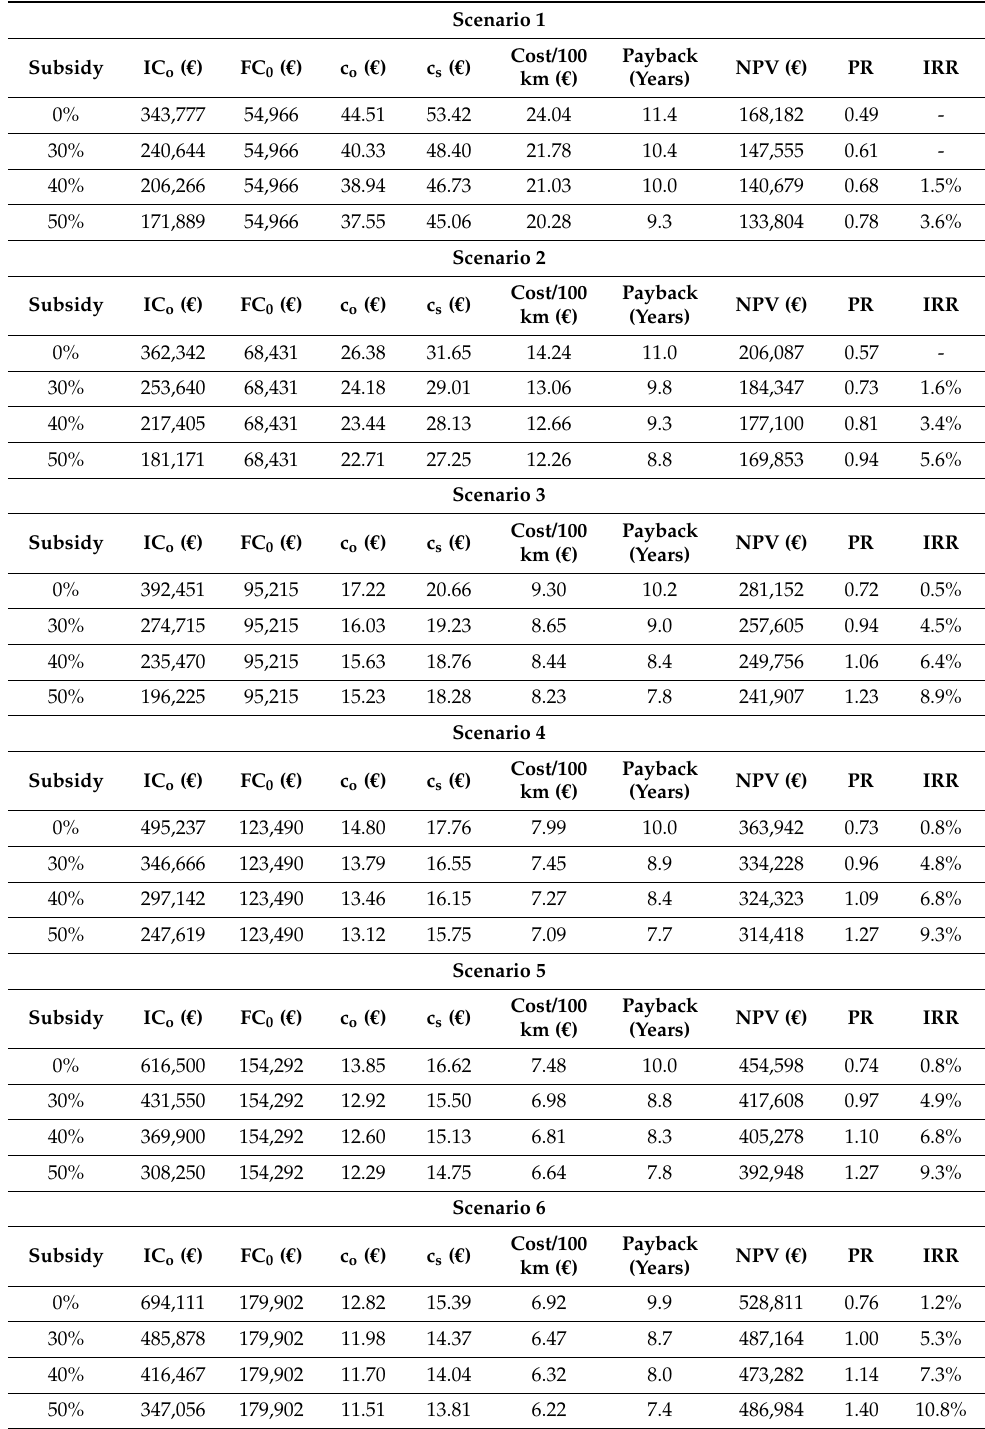
Table 4. Economic results for the six